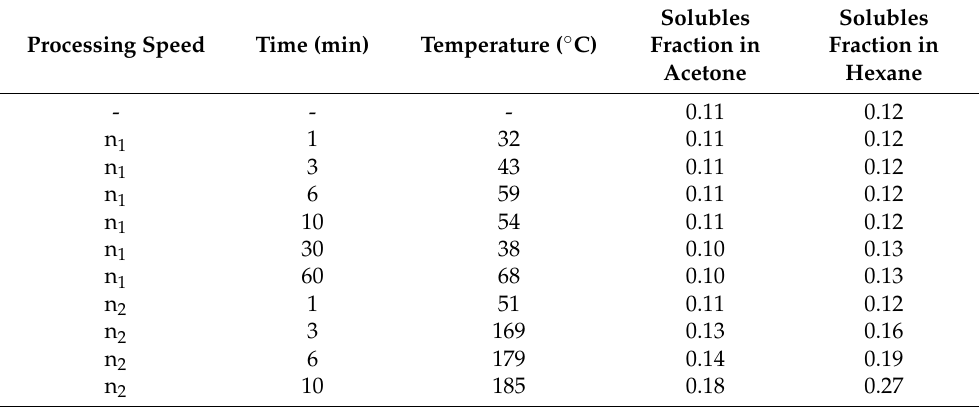
Table 1. Processing conditions, the temperature at final processing, and solubles fractions for GTR after and before mechanochemical treatment.